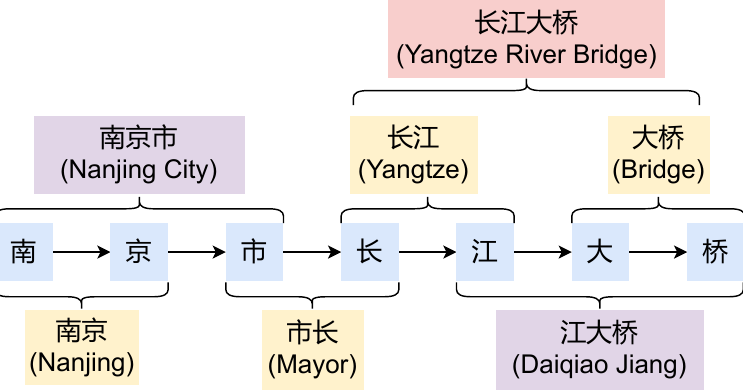
Figure 1. An example of words in a Chinese